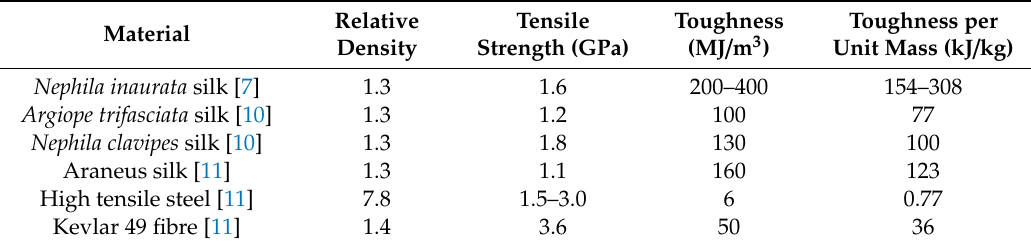
Table 1. Relative density, tensile strength, and toughness of di ff erent materials. Material